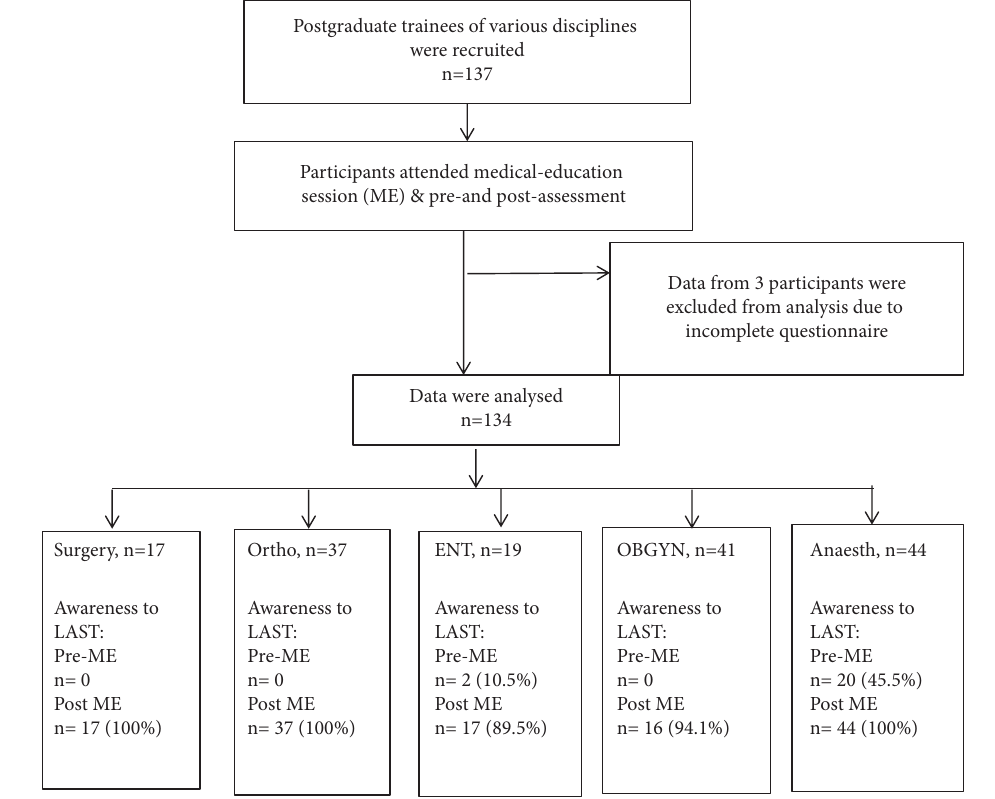
Figure 1: Study methodology and the primary outcome. Table 1: Participants’ demographic data and frequency of LA use.